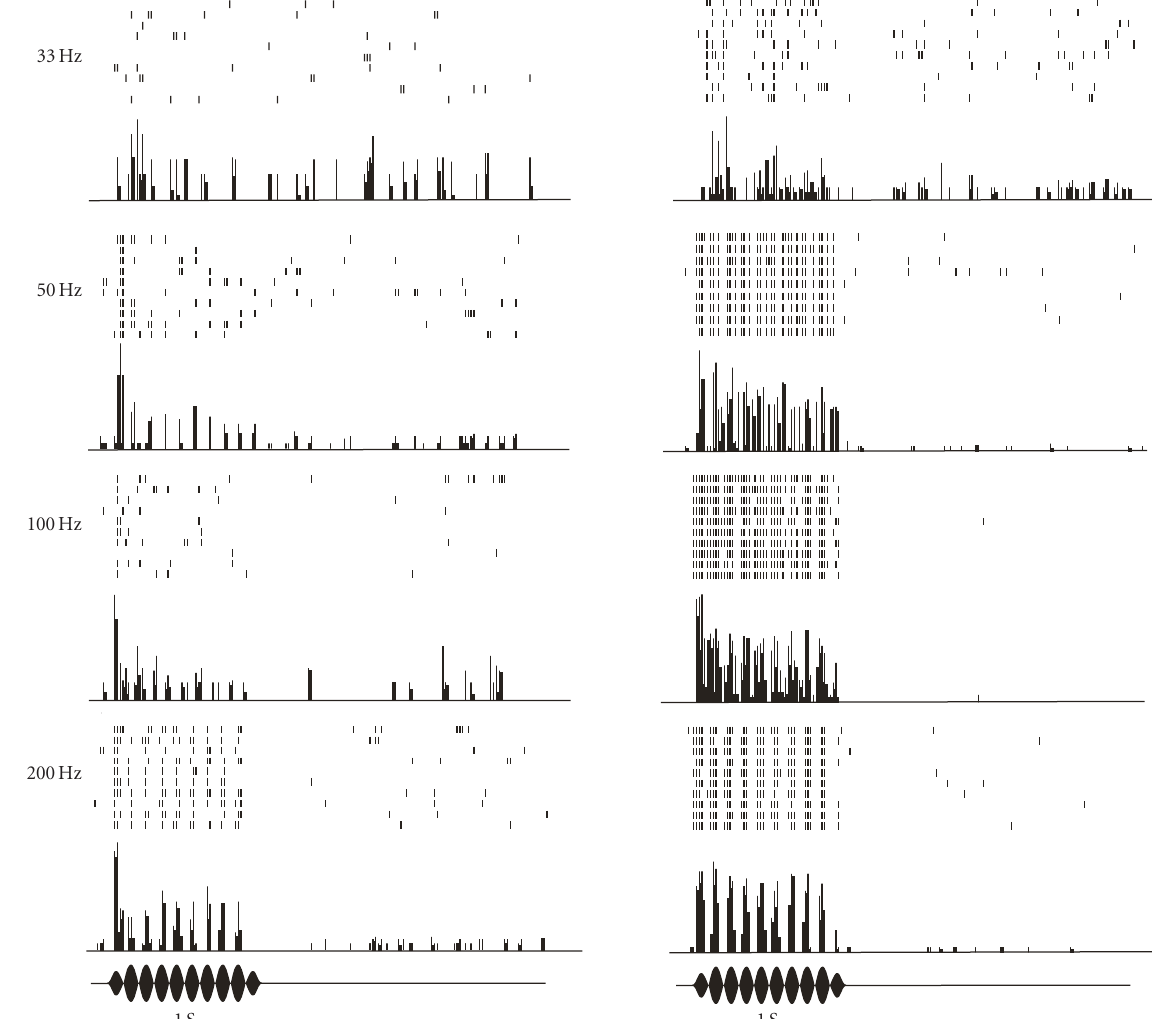
Figure 7: Discharge patterns of two MON units (left and right) in response to 10Hz AM stimuli (CF 33, 50, 100 or 200 Hz). The units clearly phase coupled to the 10 Hz AM frequency.